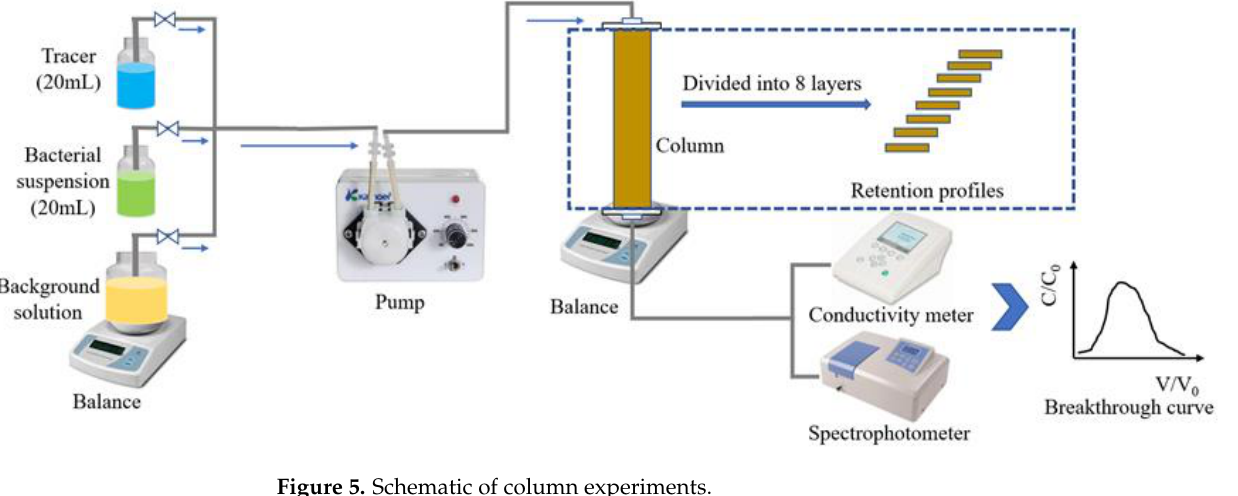
Figure 5. Schematic of column experiments. After bacterial transport experiments, the sandy porous media inside each column